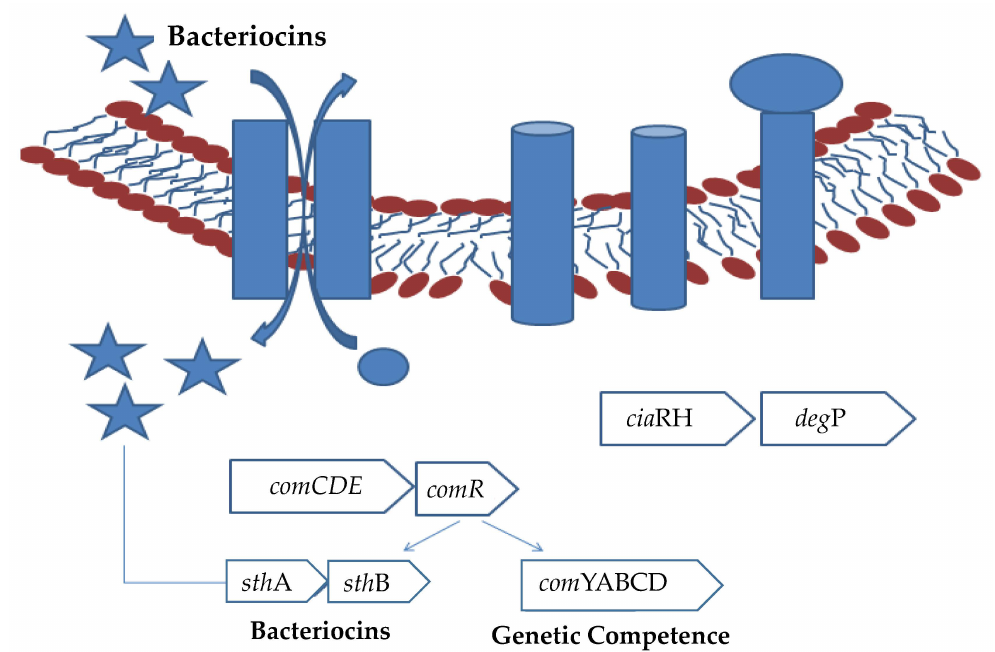
Figure 1. Genetic regulation in the production of bacteriocin production by LAB. Upregulation of the genes results in the production of the bacteriocins. The star symbols indicate bacteriocins. Circles indicate the proteins being produced within the